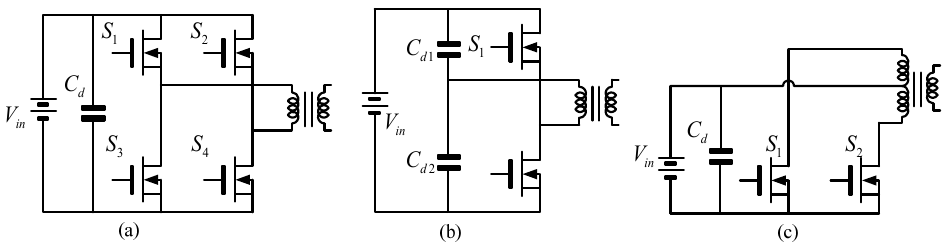
Figure 5 . Basic voltage source converters: ( a ) Full–bridge, ( b ) Half–bridge, ( c ) Push–pull [7].